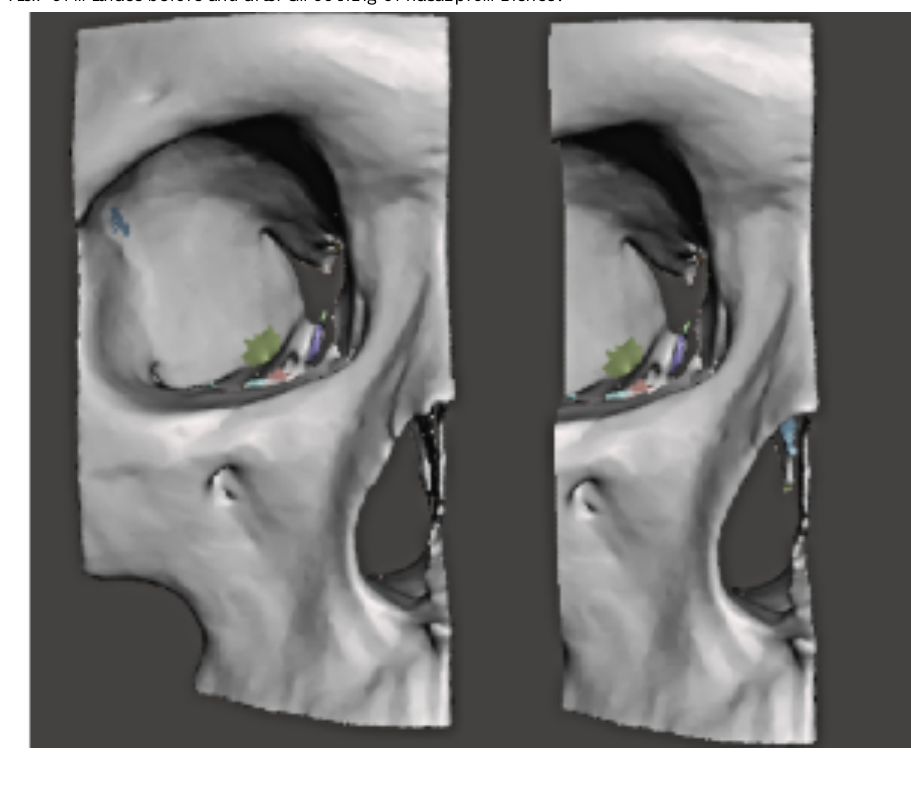
Figure 4. Original (yellow) and mirrored (silver) midface